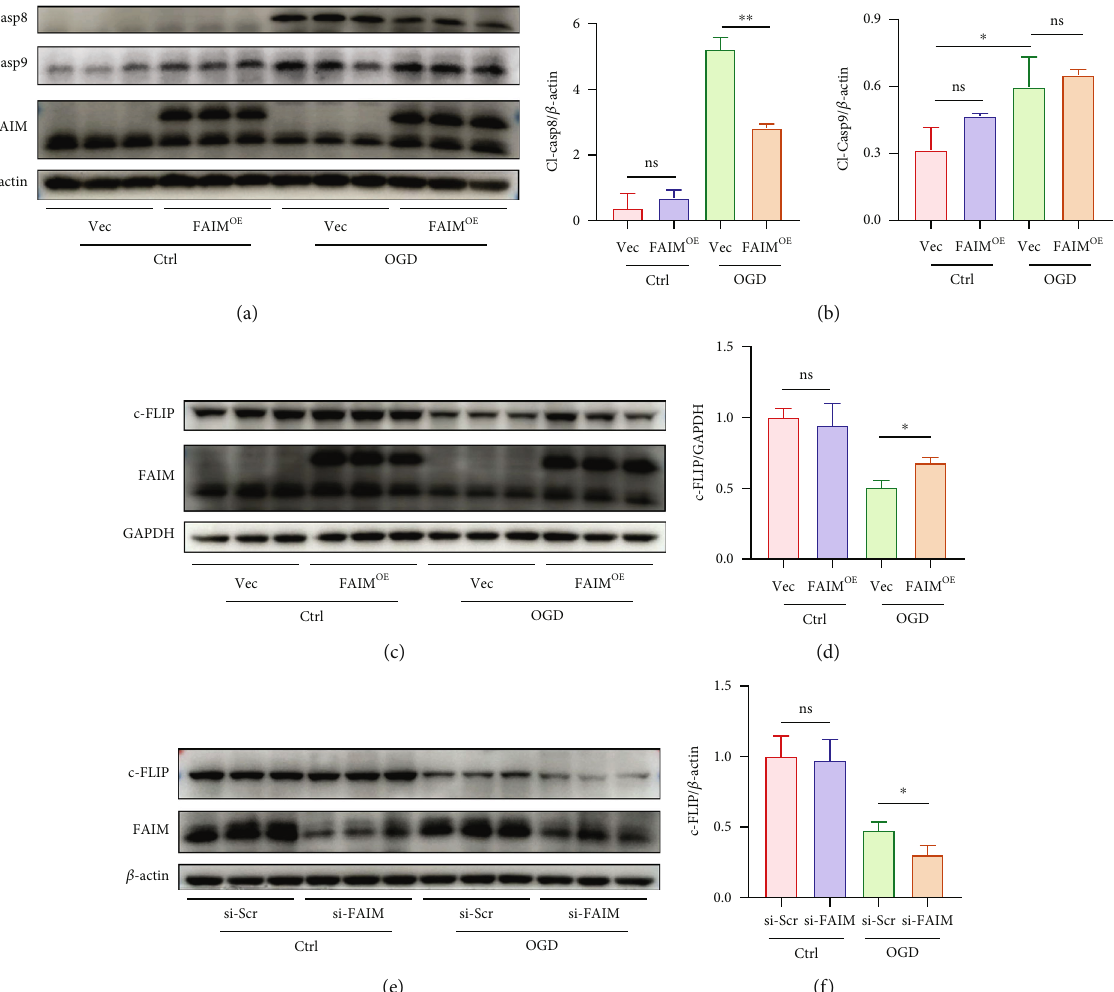
Figure 3: FAIM regulated the expression of c-FLIP in MSCs under OGD conditions. (a – b) Immunoblots and densitometric quantitation of cleaved caspase-8 and cleaved caspase-9 protein levels in MSCs densitometric quantitation of c-FLIP protein levels in MSCs siRNA-mediated knockdown of FAIM or scrambled siRNA administration followed by OGD stimulation for 12 h. The results of densitometric quanti fi cation are shown on the right. The data are shown as the mean ± SD . Ns indicates not signi fi cant; ∗ denotes P < 0 : 05 , ∗∗ P < 0 : 01